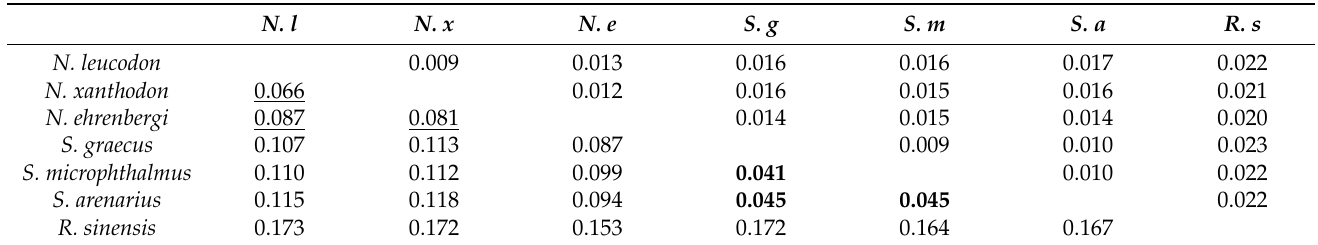
Table 3. Evolutionary divergence over sequence pairs between superspecies and outgroups inferred from the comparison of 16S rRNA gene sequence data. Standard error estimates are shown above the